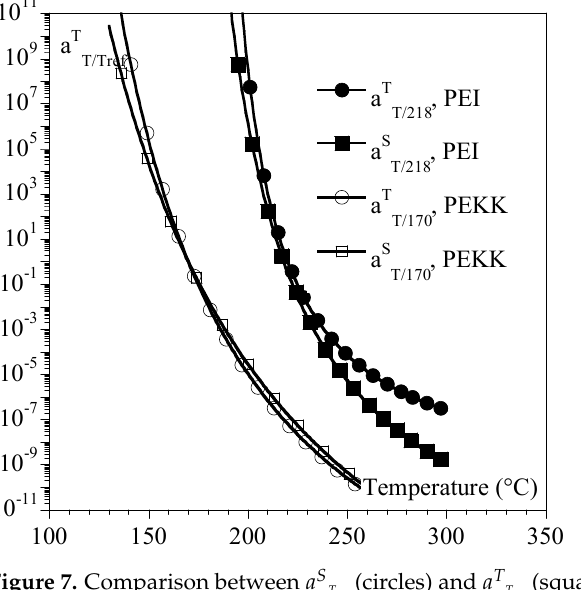
Figure 7. Comparison between a S Figure 7 . Comparison between 𝑎 (cid:3021) PEKK (hollow symbols). Curves were recalculated from parameters in Table 1. (hollow symbols). Curves were recalculated from parameters in Table